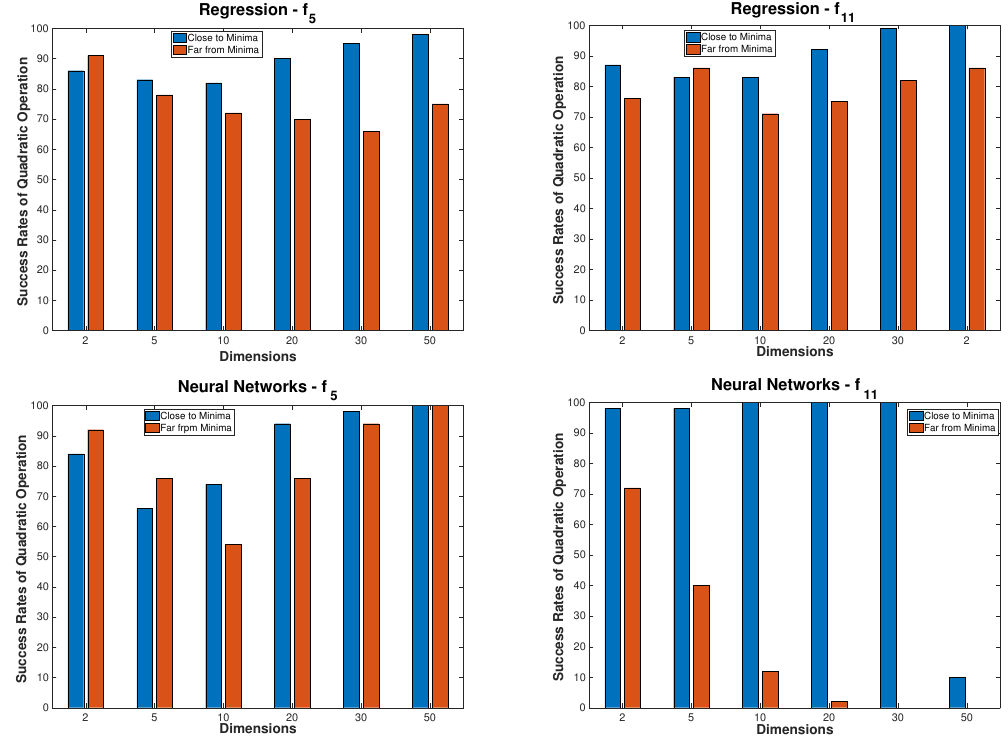
Figure 8. Performance of the quadratic operations near or far from